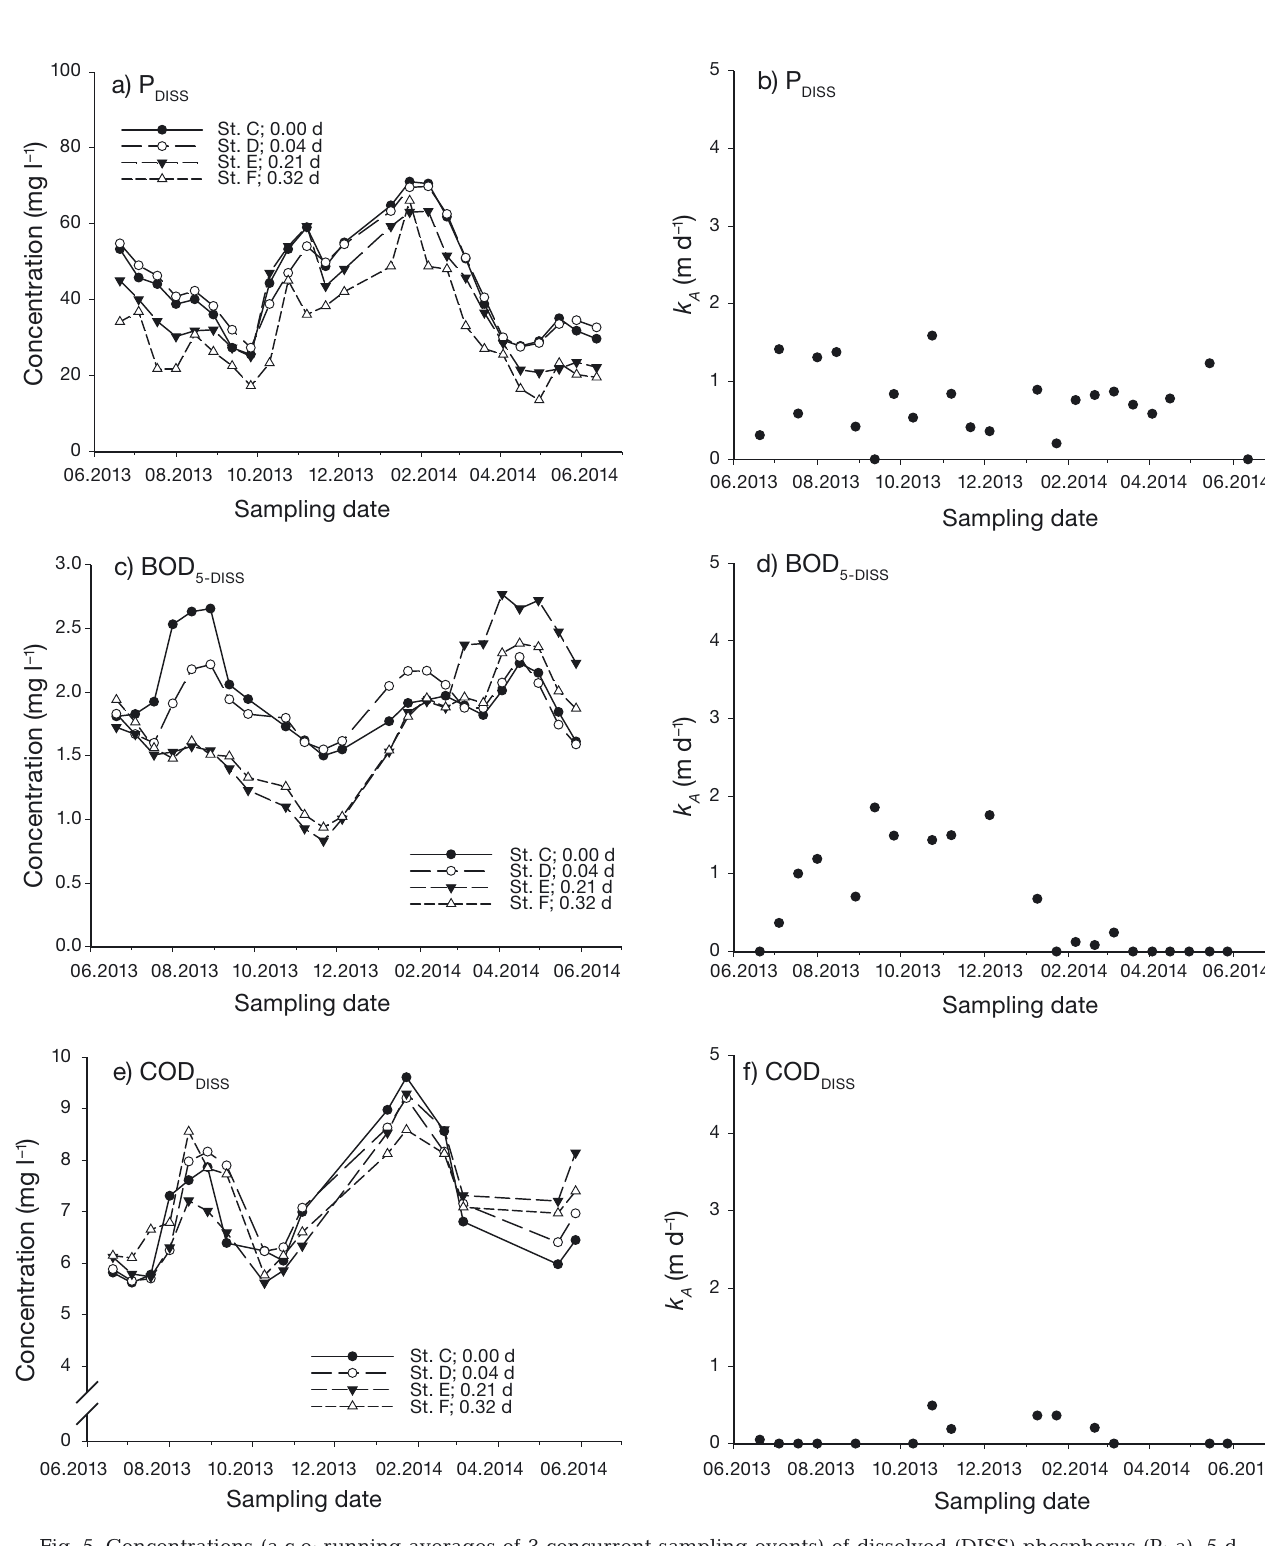
Fig. 5. Concentrations (a,c,e; running averages of 3 concurrent sampling events) of dissolved (DISS) phosphorus (P; a), 5 d biochemical (BOD 5 ; c) and chemical (COD; e) oxygen demand measured at increasing hydraulic retention time (HRT, in d) relative to the wetland inlet station (Stn C, cf. Fig. 1) during the year of bi-weekly sampling. Also shown is the corresponding area-based reaction coefficients ( k A , m d −1 ; b,d,f). Background concentrations used for fitting first order kinetic plug flow models to the longitudinal transect data and deriving the k A values are summarized in Table